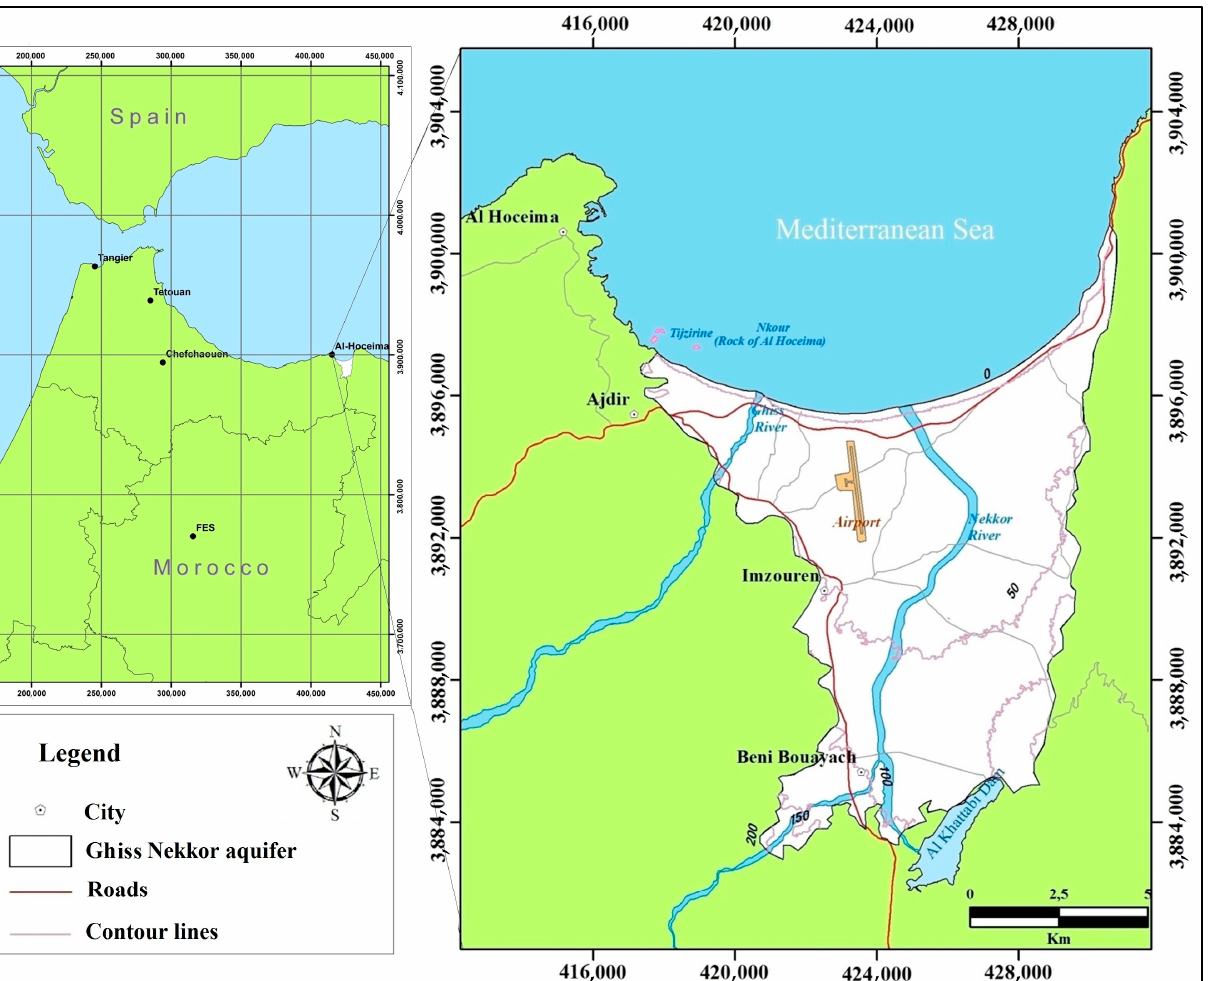
Figure 1. Geographical location of the Ghiss Nekkor aquifer.